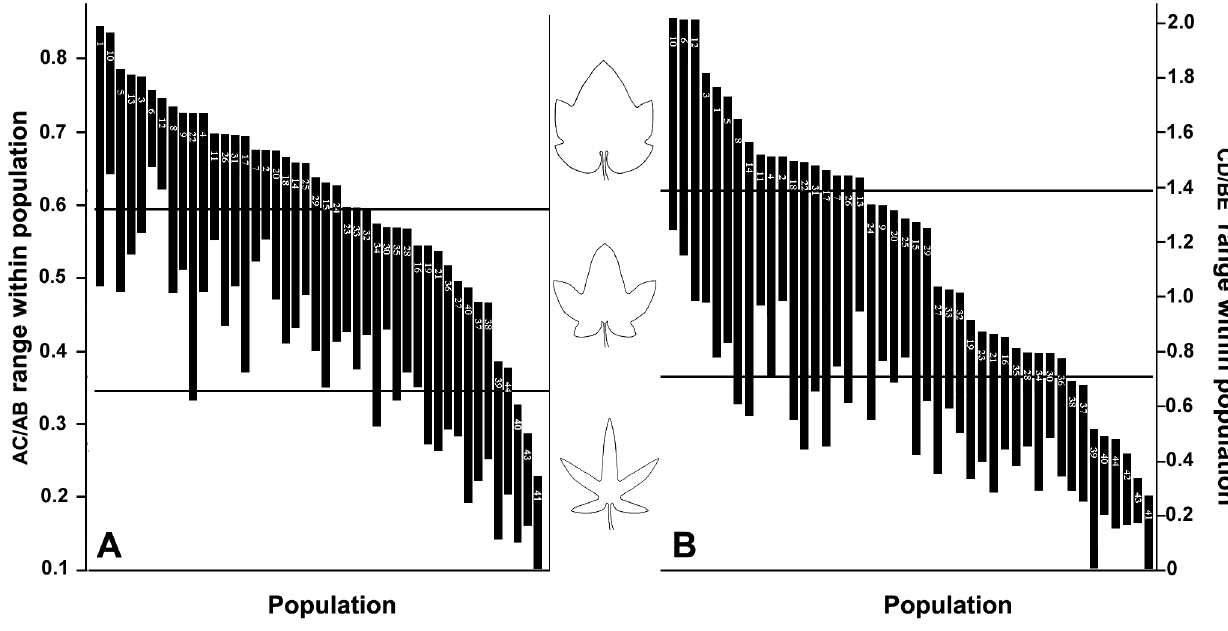
Figure 5. Range of variation of AC/AB (A) and CD/BE (B) values within the studied populations.